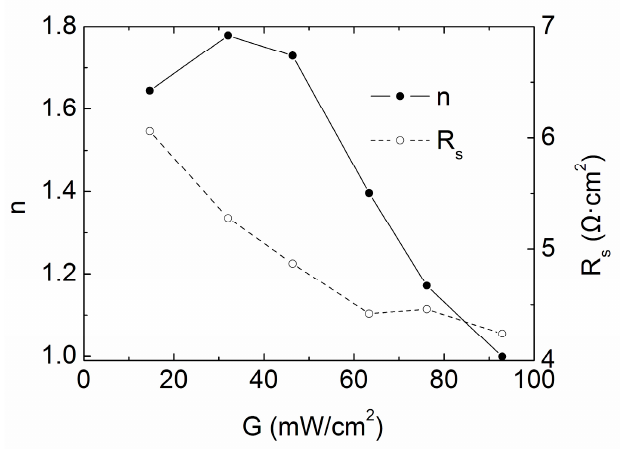
Figure 4. Intensity G versus n and R s under low intensity illumination condition for cell #1.